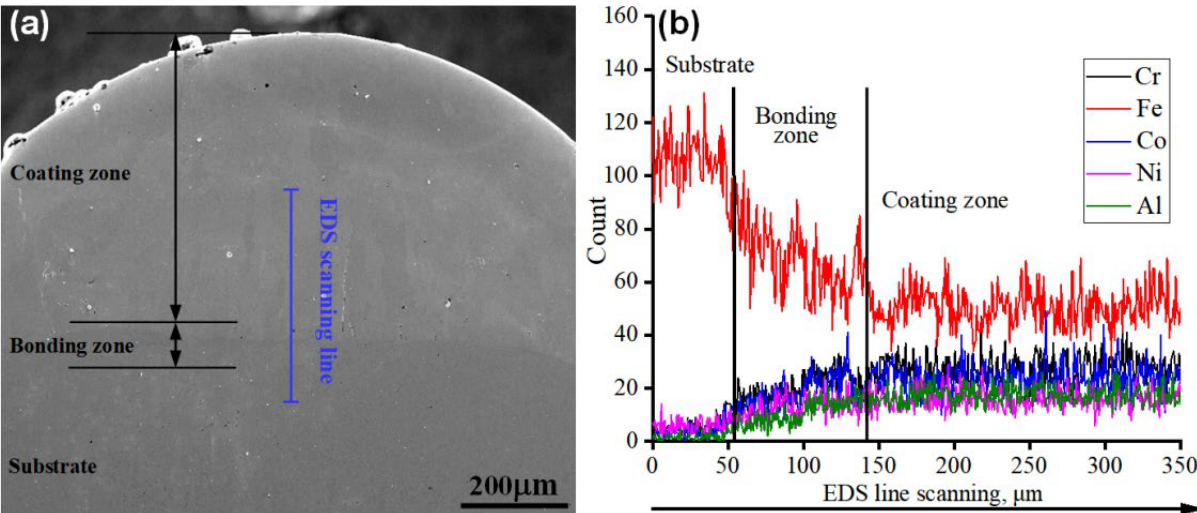
Figure 3. ( a ) SEM morphology of cross-section of the FeCoCrNiAl single cladding track, and ( b ) element distribution along the height direction.